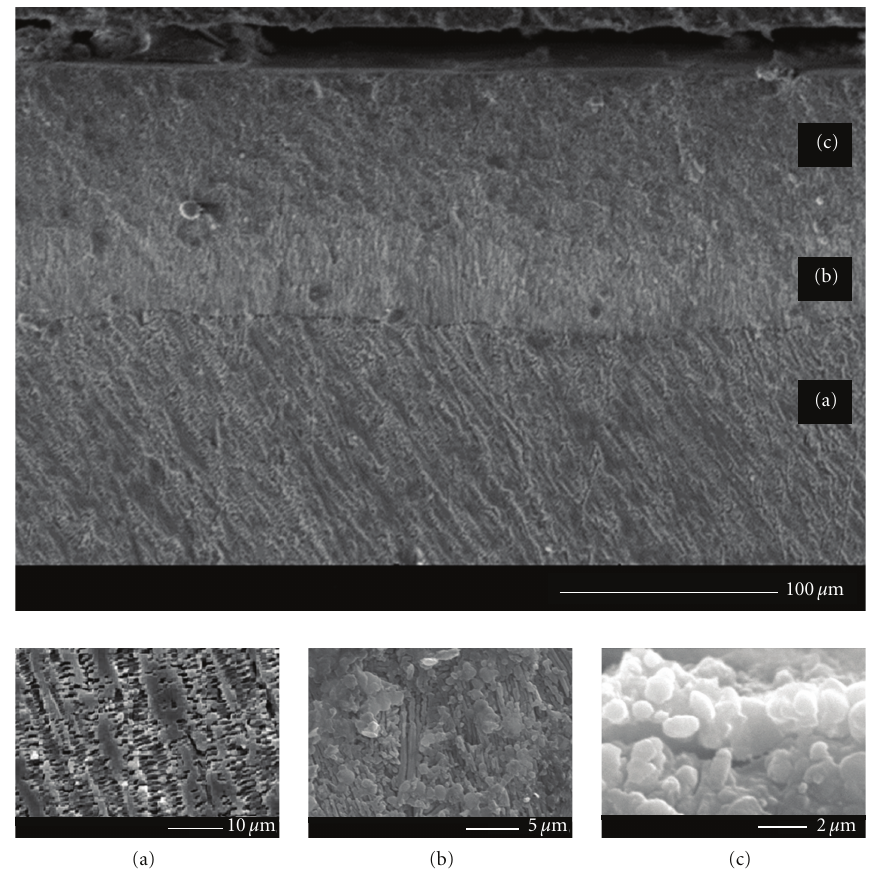
Figure 10: SEM image of β -spodumene-based glass ceramic monolith prepared at 875 ◦ C for 15 min: (a) parent glass; (b) first crystallization front; (c) second crystallization